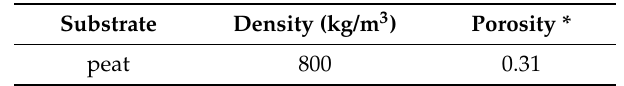
Table 1. Physical properties of the peat applied in this study.